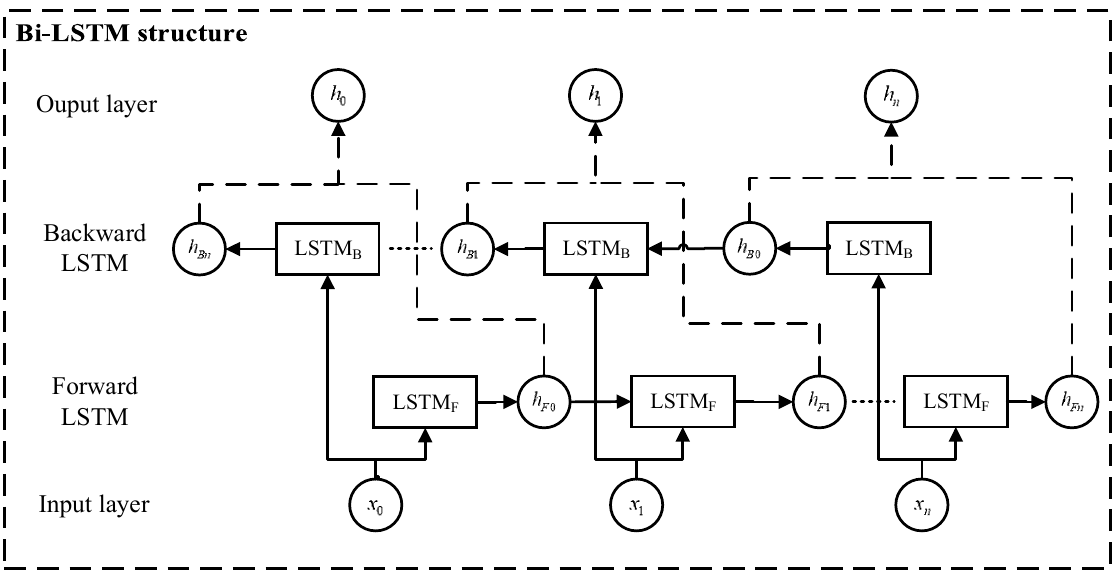
Figure 3. Bi-LSTM structure.